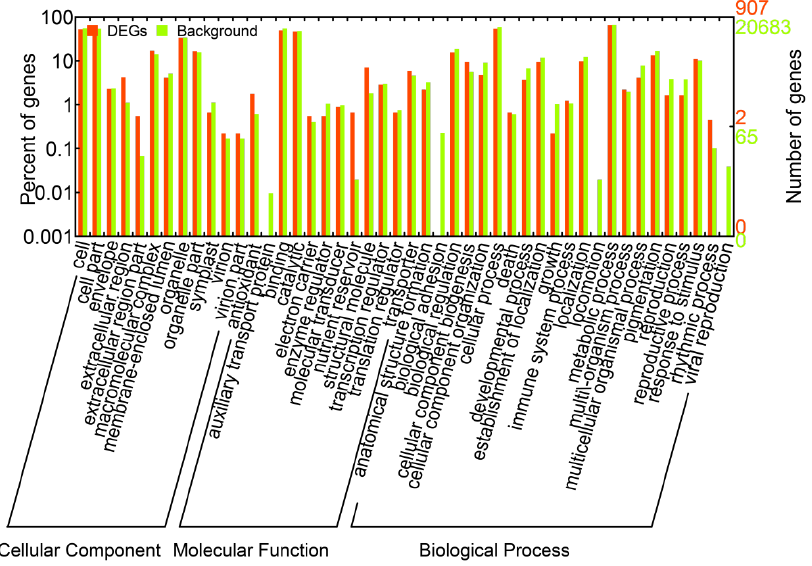
Figure 3. Gene ontology classifications of all of the unigenes and DEGs in A. splendens .